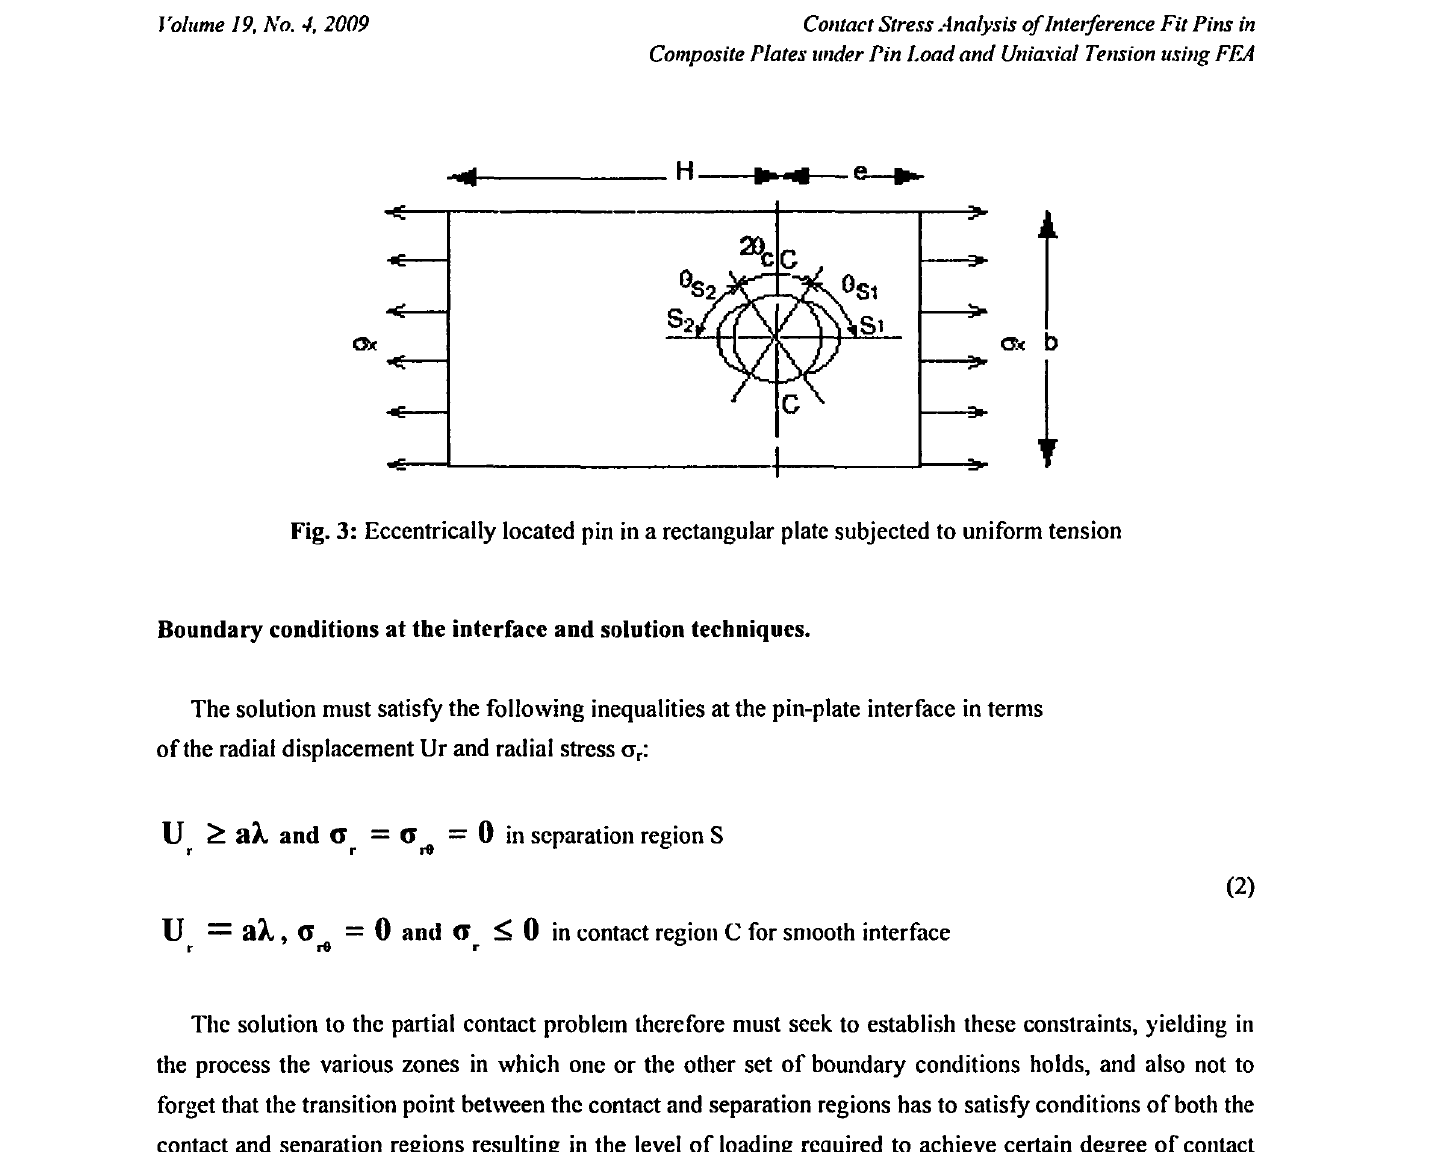
Boundary conditions at the interface and solution